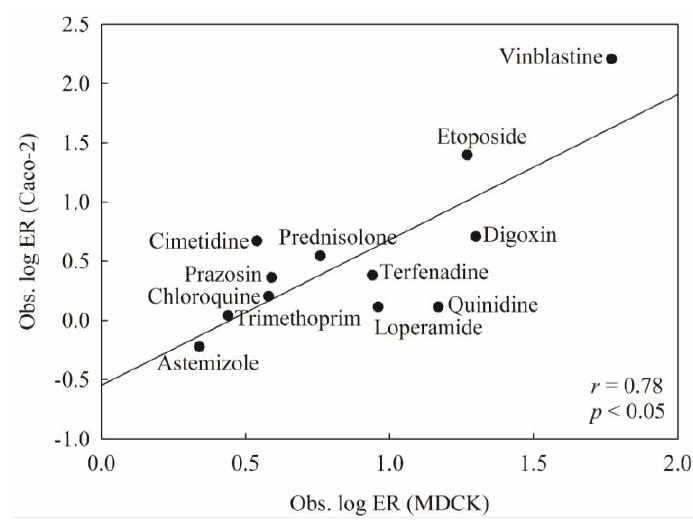
Figure 4. The observed log ER values (Caco-2) vs. the observed log ER values (MDCK).